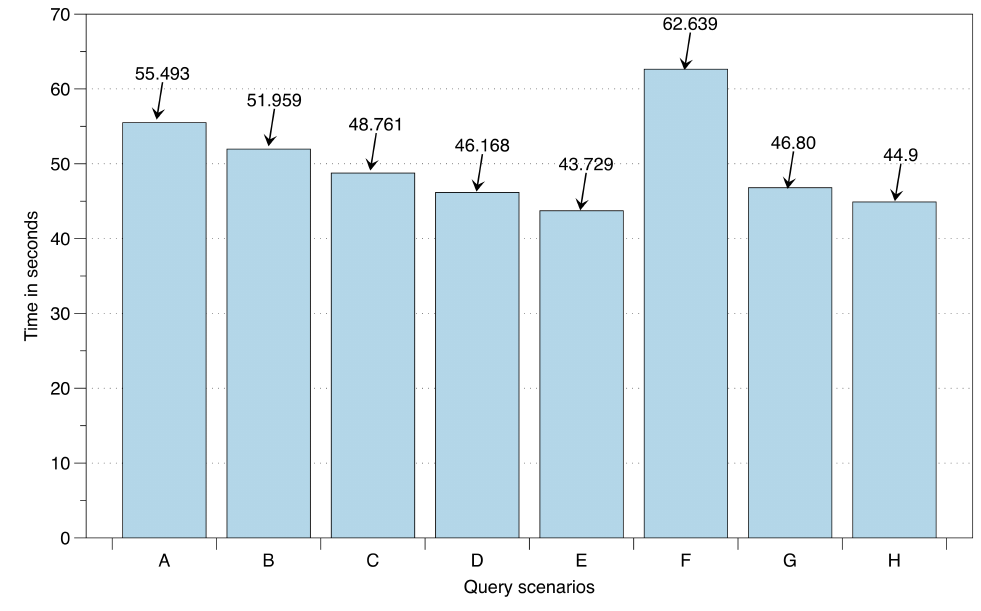
Figure 19. Query execution and response time over big data